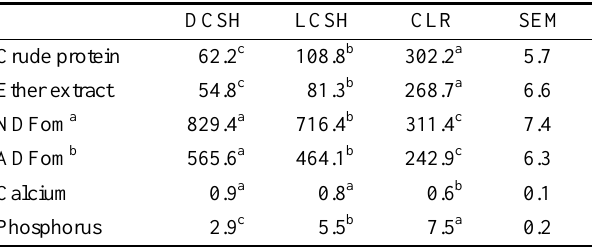
Table 1 . Chemical composition (g/kg DM) of delinted cottonseed hulls (DCSH), linted cottonseed hulls (LCSH) and cottonseed linter residue (CLR)